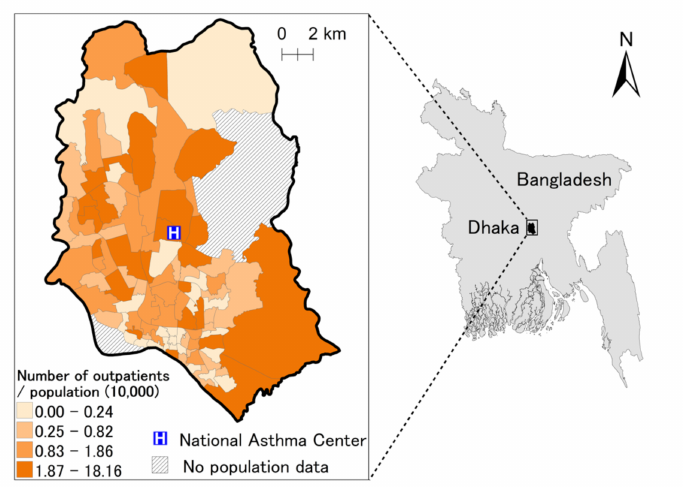
Figure 1. Location of the hospital and the number of outpatients (per 10,000 population), February– November 2013. Information of administrative area boundary was collected by Dhaka City